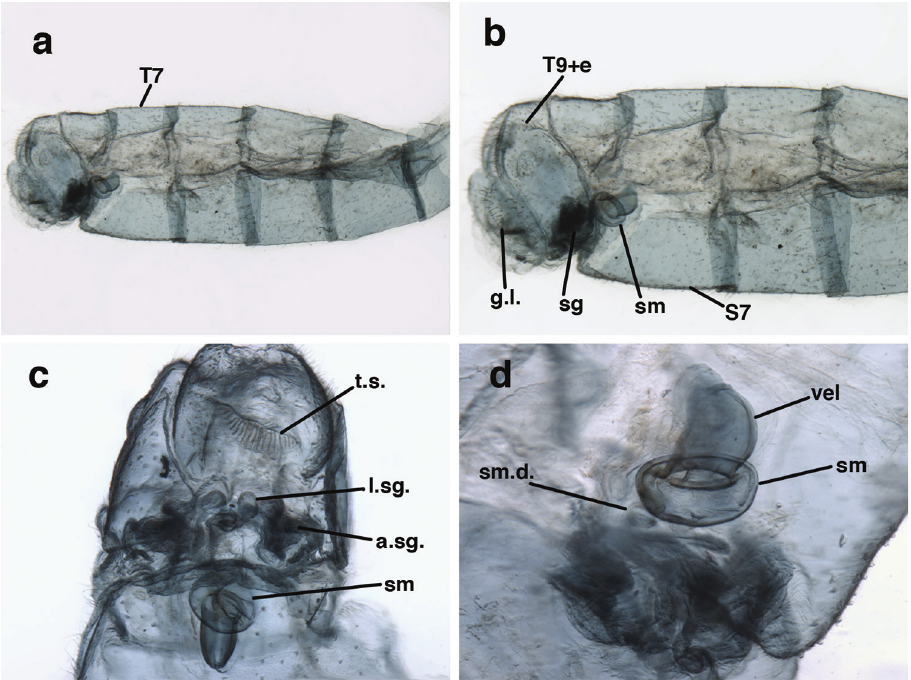
Figure 139. Chrysopa steinbachi Navás. Female abdomen and genitalia, ( a ) segments A4-terminus, lateral ( b ) terminalia, lateral ( c ) terminalia, ventral ( d ) spermathecal complex, lateral. a.sg. lateral arm of subgenitale g.l. gonapophysis lateralis l.sg. lobe of subgenitale sg subgenitale sm spermatheca sm.d. spermathecal duct S7 seventh sternite t.s. transverse sclerite T7 seventh tergite T9+e ninth tergite and ectoproct vel velum (Argentina, Tucumán, holotype, ZMB). Prothorax wide, probably with pair of broad, brown, lateral stripes, thin, brown mesal stripe; transverse furrow in mesal region, not reaching lateral margins; with short to long, mostly pale setae throughout. Mesothorax, metathorax greenish with yellow mesally. Measurements: head width, 1.4 mm; ratio head width : eye width, 2.5 : 1; prothoracic length, 0.8 mm; prothoracic width, 1.1 mm. Forewing, hindwing clear, hyaline, without fumose areas, with slender venation; stigma lightly opaque, with five brown to dark brown subcostal crossveins below stig- ma; most veins of forewing cream-colored to light green, basal subcostal crossvein, base of Rs, base of M-Cu crossvein, branches of anal veins darkened, intersections of most veins, crossveins marked with small brown spot; veins of hindwing paler than those on forewing, mostly without brownish marks at intersections. Forewing 14.8 mm long, 5.4 mm wide (ratio, L : W = 2.8 : 1); height of tallest costal cell 1.0 mm (cell number 6); width of first intramedian cell 1.0 mm; 13 radial cells (closed cells between R and Rs); third gradate cell 1.80 mm long, 0.44 mm wide (ratio, L : W = 4.06); fourth gradate cell 1.74 mm long, 0.40 mm wide (ratio, L : W = 4.39); 5